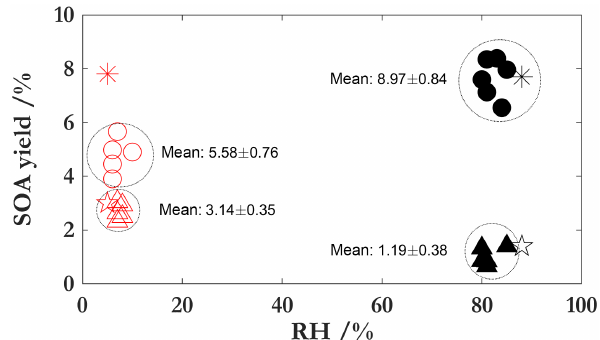
Figure 3. Maximum yields of SOA from toluene and isoprene under dry (red color) and humid (black color) conditions ( ◦ : toluene-NO 2 - hν ; (cid:52) : isoprene-NO 2 - hν ; (cid:63) : isoprene-O 3 ; ∗ : isoprene-H 2 O 2 - hν